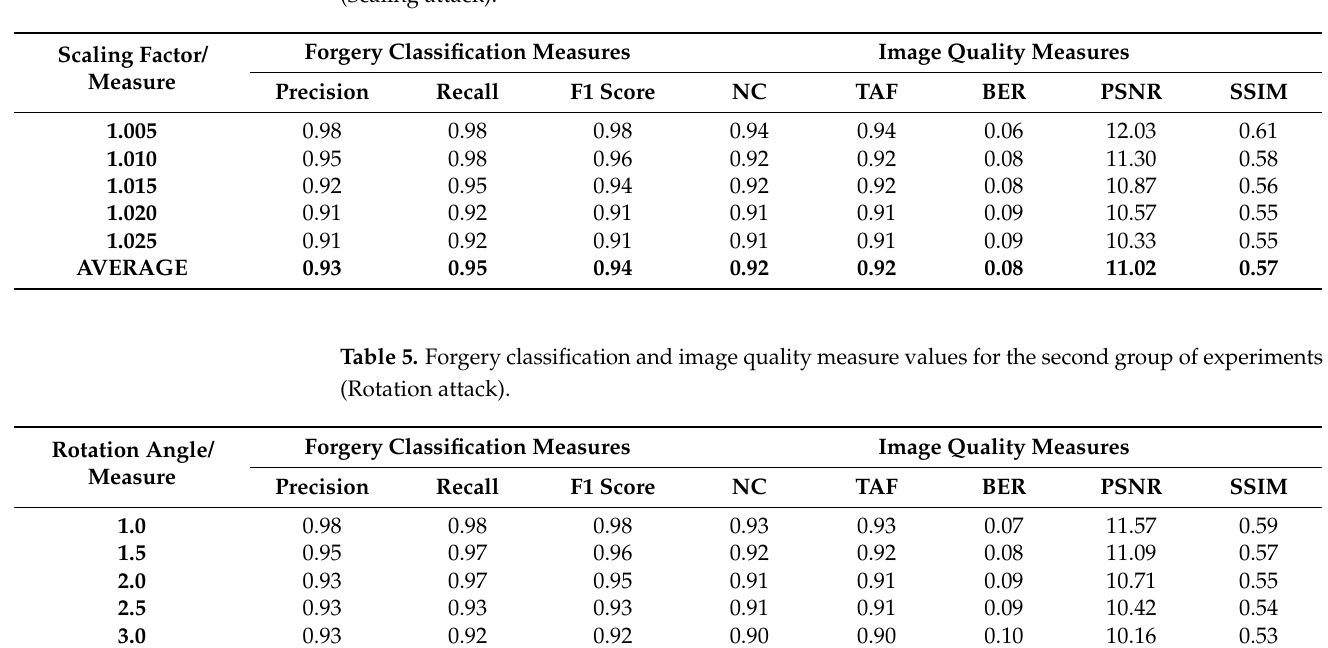
Table 4. Forgery classification and image quality measure values for the second group of experiments (Scaling attack).